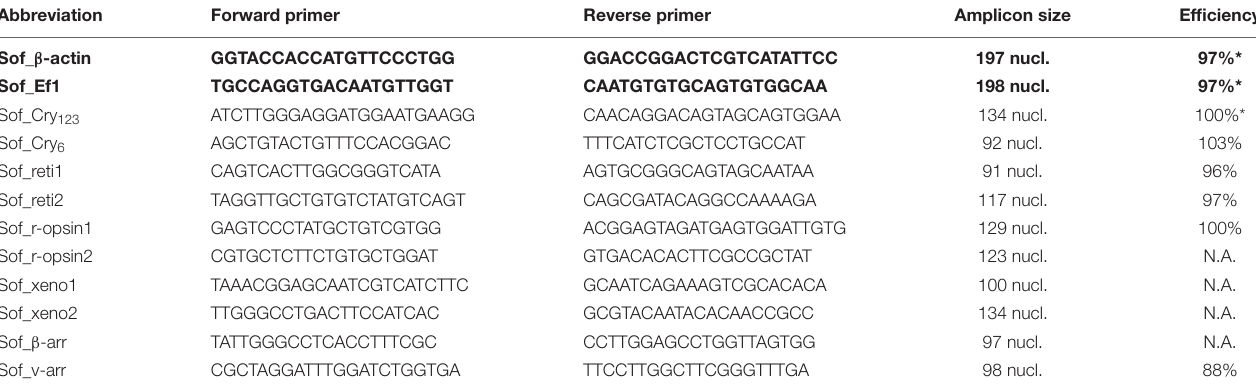
TABLE 1 | Primers for RT-qPCR experiment. Sof_ β -actin and Sof_Ef1 (bold) were used as reference